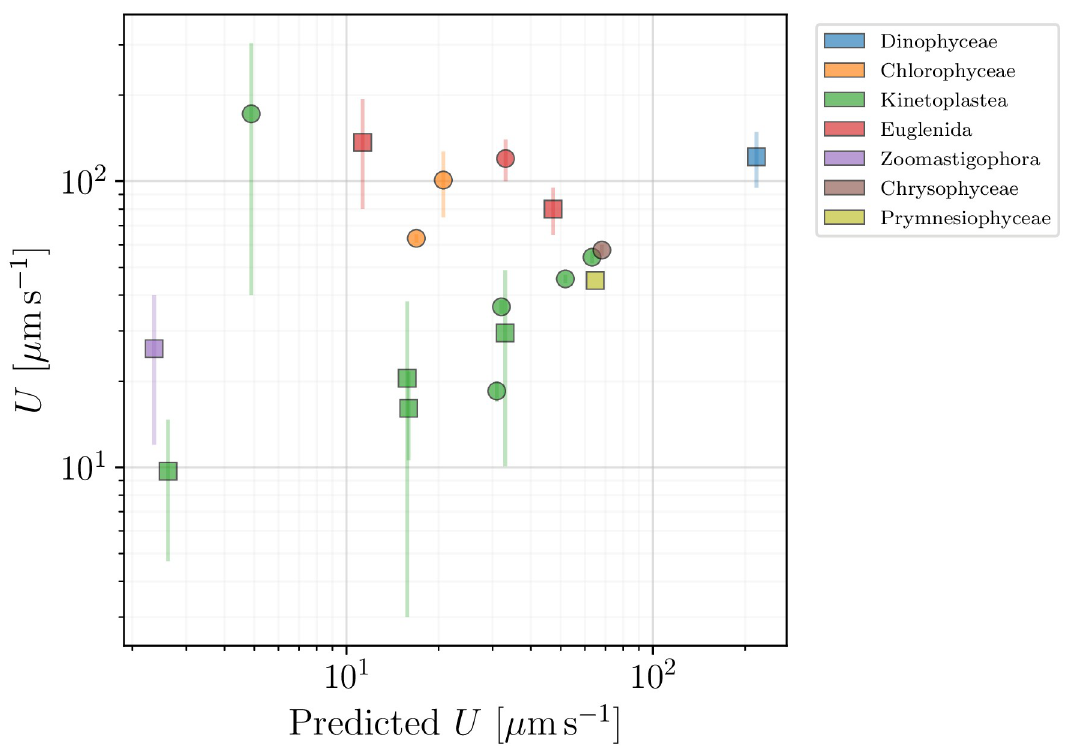
Fig 13. Swimming speeds of flagellated eukaryotes (excluding spermatozoa and ciliates) reported in the database plotted against the theoretical prediction of Eq (28). Colours mark different classes. Square symbols mark organisms for which the prediction was directly calculated from the available data, while circles represent organisms for which either the body width or one of the flagellar characteristics has been estimated (see text for details).